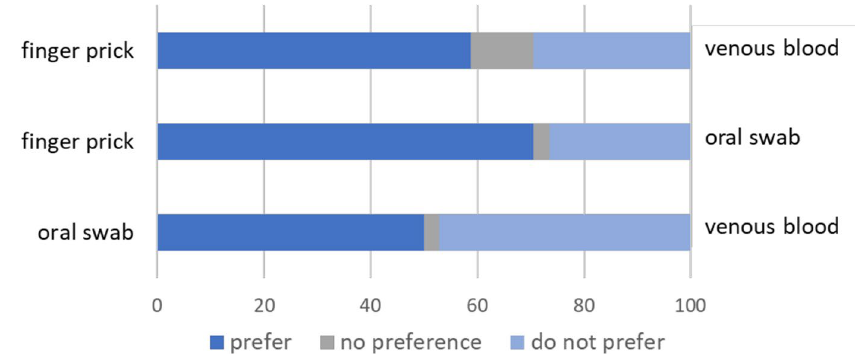
Fig. 2 Pairwise specimen preference among caregiv- ers comparing oral swab, venous blood and finger prick collection methods. (n = 34) Participants were asked pair-wise specimen prefer- ence types, and stated either: preferred, no preference, or did not prefer one speci- men over another. Only one response allowed per